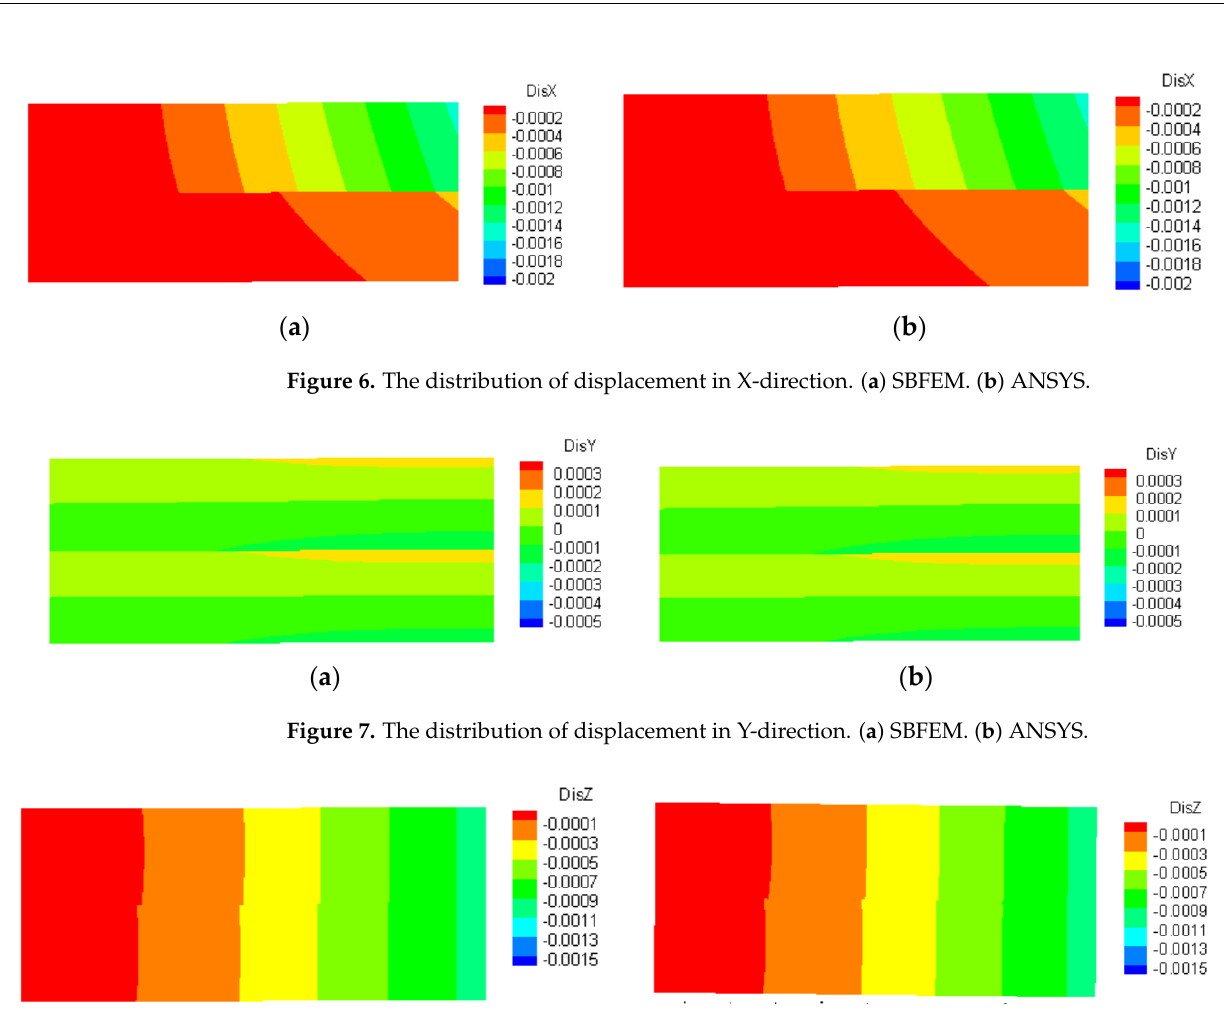
Figure 6. The distribution of displacement in X-direction. ( a ) SBFEM. ( b ) ANSYS.